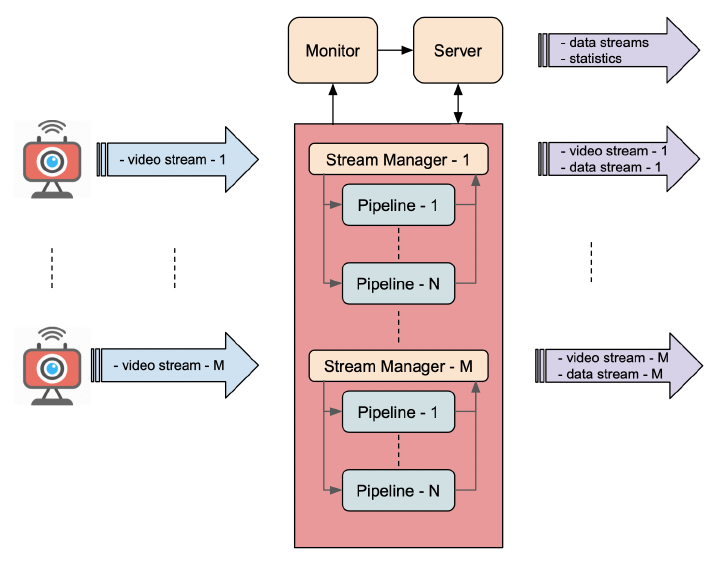
Figure 2. Functional architecture of Deep-Framework. The system is able to process multiple video streams at once through one or more pipelines that are responsible for information extraction.